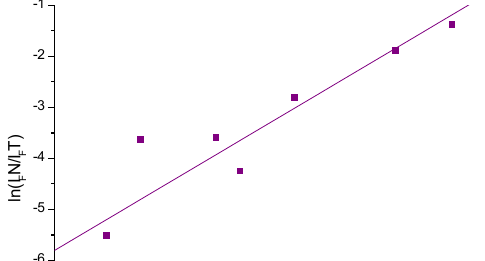
Figure 10. Solvatochromism of bis-flavonol: plots of positions of the absorption (top, blue), normal fluorescence (middle, green) and phototautomer fluorescence bands (bottom, red) versus Reichardt solvent polarity index E TN ; see colors in the online version of this paper.